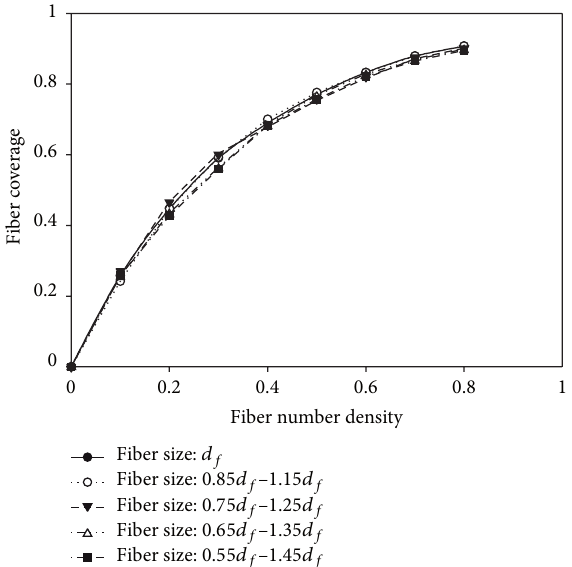
Figure 6: Surface coverage of nanofibers at various number density for various size distribution.